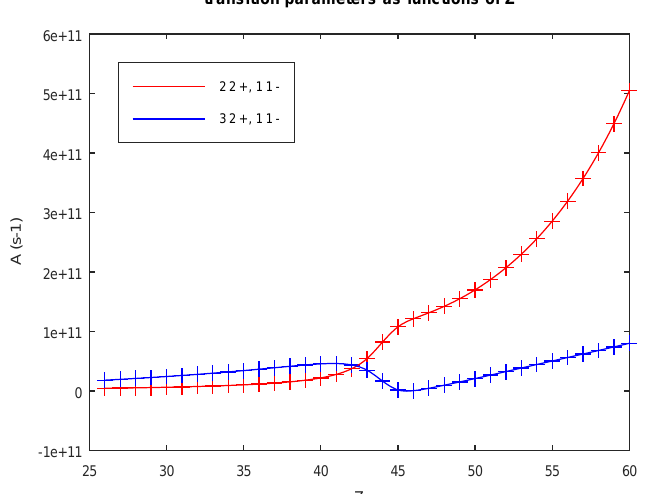
Figure 9. Plot of transition rates involving two interfering states. The M-file was edited, and we added the legend, see Section